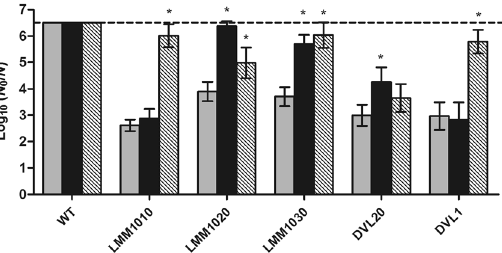
Figure 4. Logarithmic reduction factor of E. coli MG1655 WT and its evolved mutants equipped with pACYC184 (control vector; grey bars), pACYC184- crp (black bars) or pACYC184- cyaA (hatched bars) by a HHP treatment at 800 MPa for 15 min. The dotted line represents the quantification limit (1,000 CFU/ml). An asterisk indicates statistically significant differences ( P ≤ 0.05) between the inactivation of each strain equipped with pACYC184- crp or pACYC184- cyaA and the control vector.